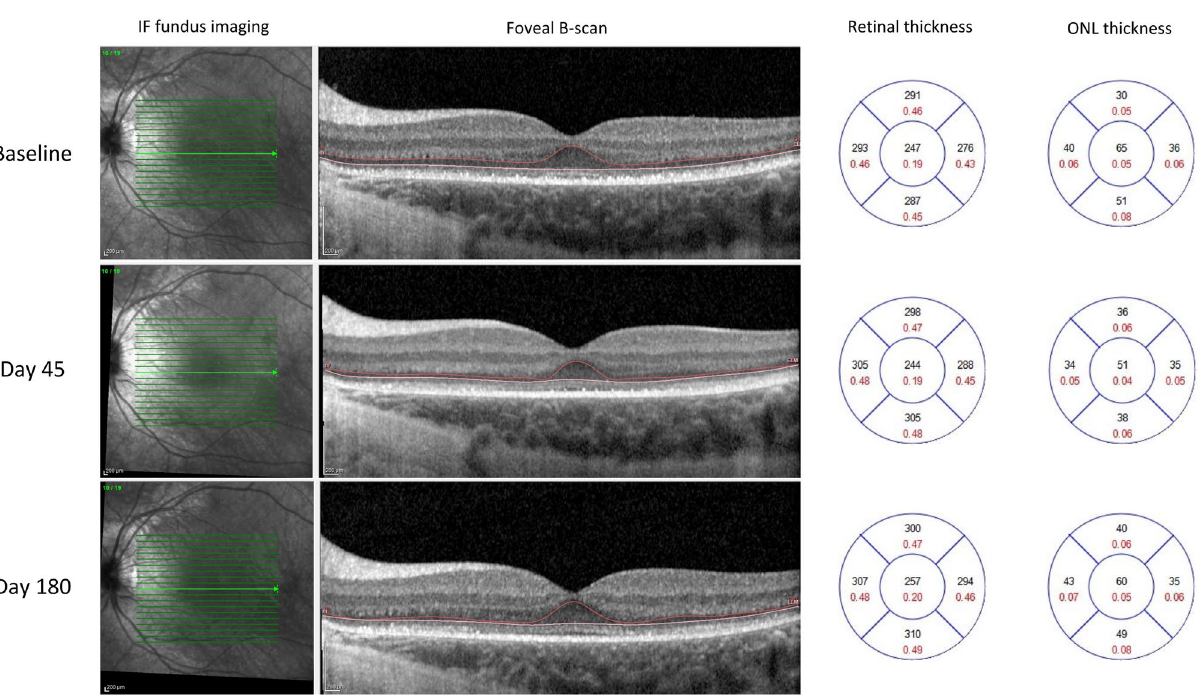
Figure 4. Retinal and outer nuclear layer (ONL) thickness analysis in the left eye of patient 6 undergoing intra- operative foveal detachment, showing a mild thinning of central subfoveal ONL after treatment with voretigene neparvovec